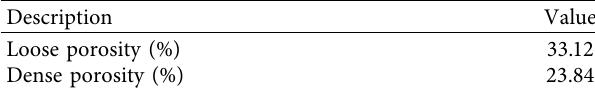
Table 3: Porosity of whole tailings.